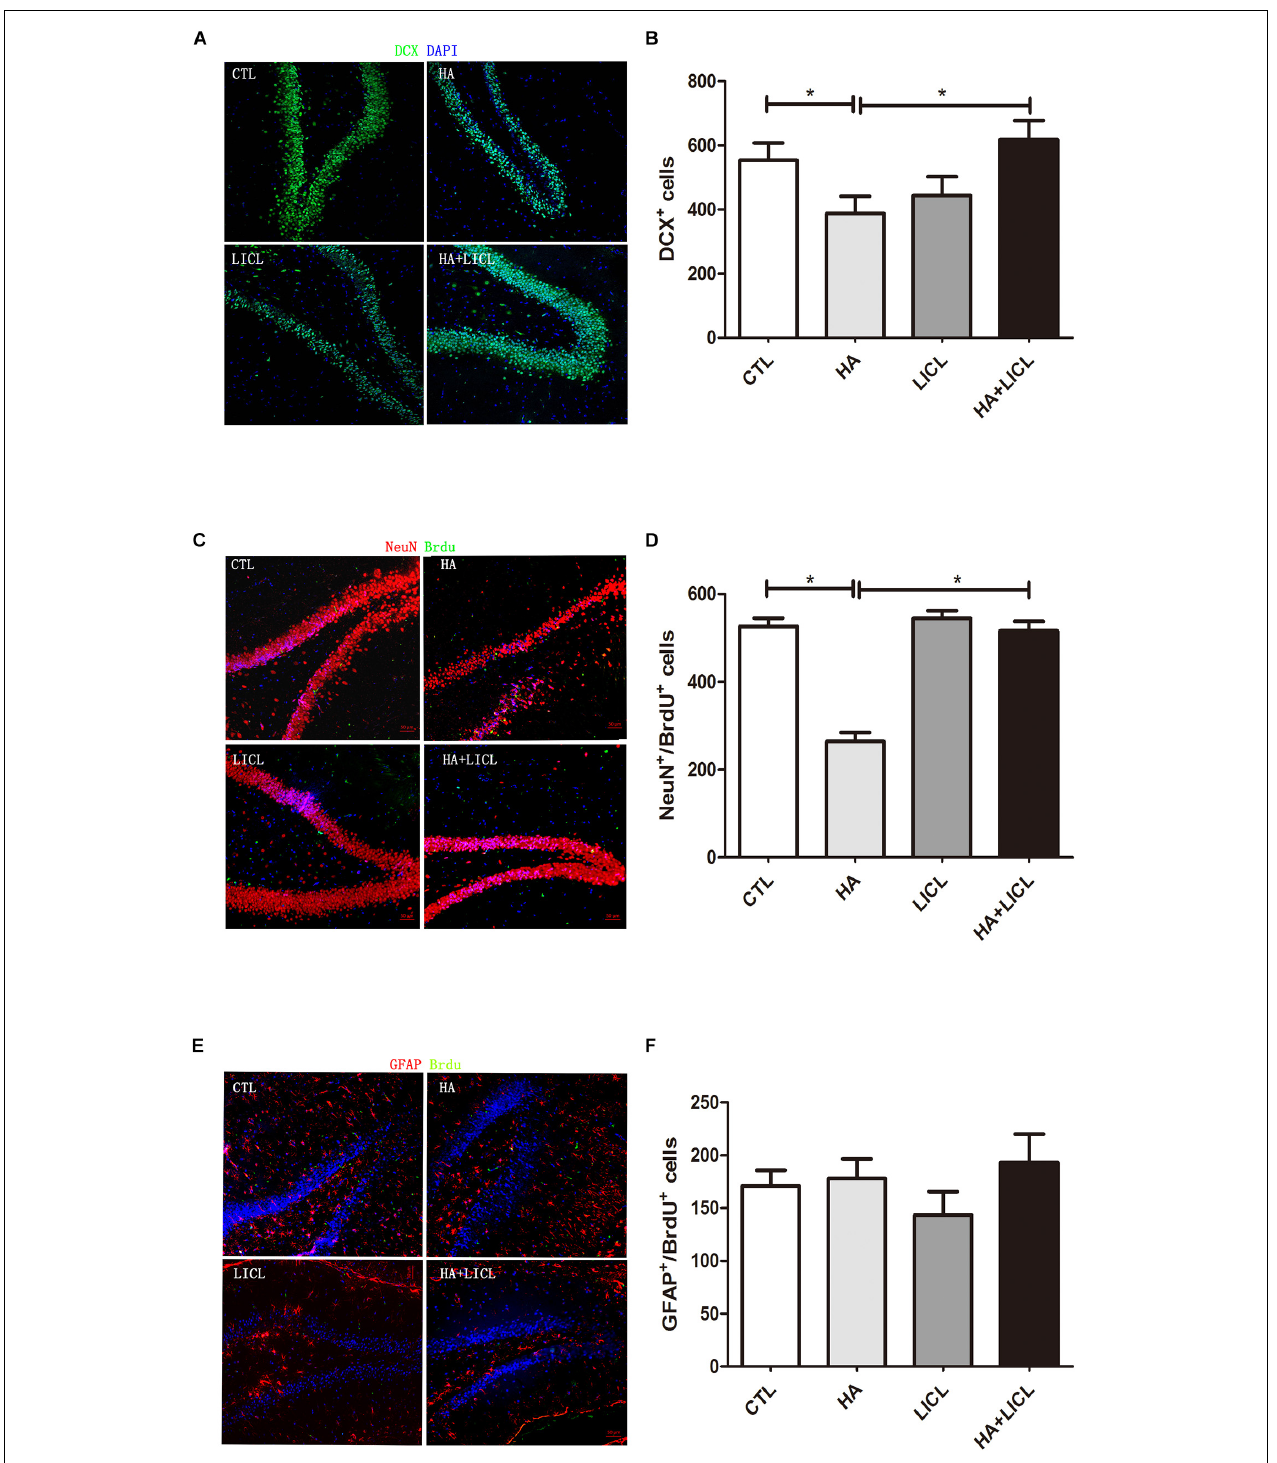
FIGURE 3 | The neurogenesis of DG area among different treatment groups. (A,B) The number of DCX positive neurons of the rat DG area was significantly decreased in HA group as compared to CTL group, and after lithium chloride treatment the number of DCX positive neurons increased in HA+LICl group. (C,D) Brdu and NeuN neurons in the DG region were reduced, while lithium chloride promoted the proliferation of NPCS in HA+LICl group. (E,F) No significant difference was found in Brdu and GFAP neurons among the four groups. ∗ p < 0.05.